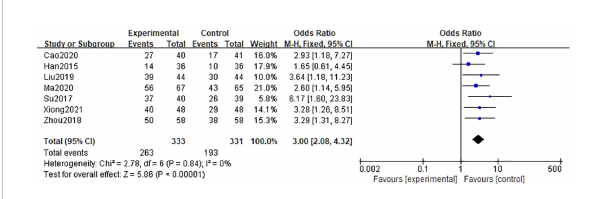
FIGURE 4 Forest analysis map of the comparison of treatment ef fi ciency. Odds ratio (OR) is a way of describing probability; M-H,